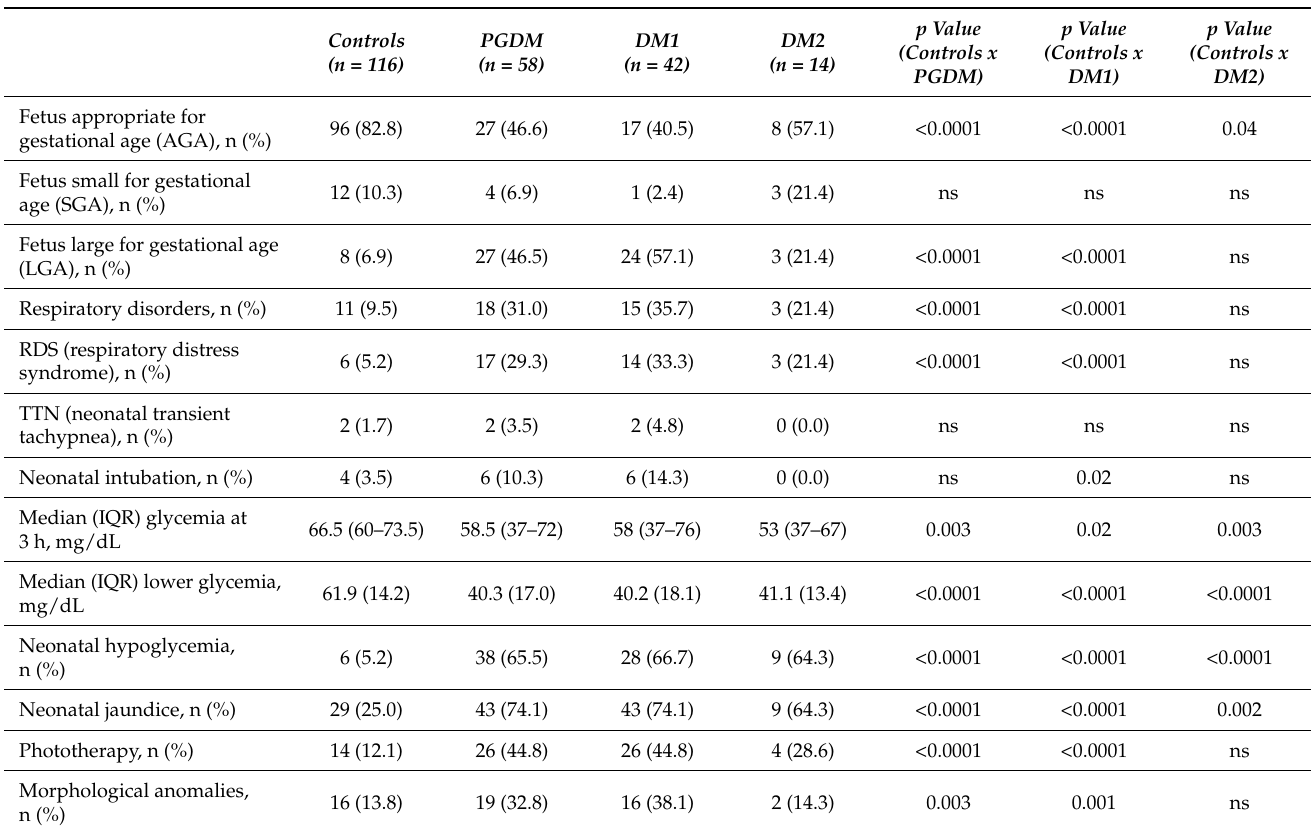
Table 2. Neonatal outcomes.